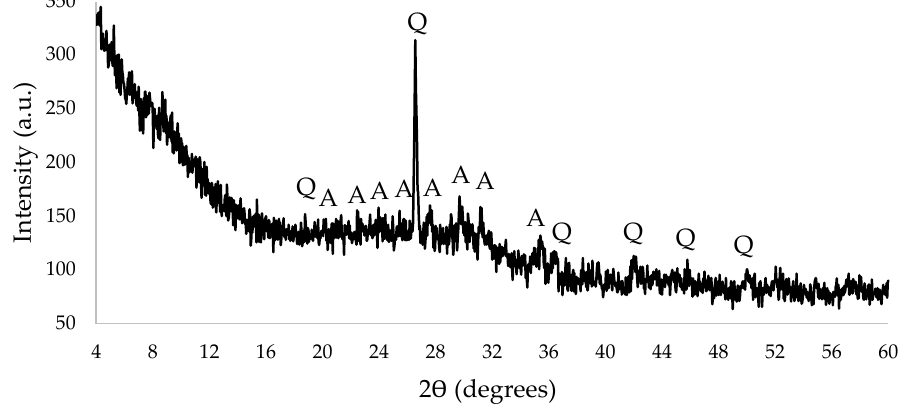
Figure 2. X-ray of MSWI BA (Q—quar tz , A—anorthite). The heat fl ow and the total heat release rate during the hydration of the solvent (distilled water) were measured with the microcalorimeter Tam Air III (TA Instruments, New Castle, DE, USA). Glass ampoules with 20 mL of capacity were used for the experiments. They were fi lled with 3 g of dry materials and placed in the microcalorimeter. After reaching a constant temperature of 25 ± 0.1 °C, 1.5 g of distilled water was added to the ampoule. The resulting suspension was stirred at 2–3 rpm for 20 s. Heat fl ow was measured for 40 h.